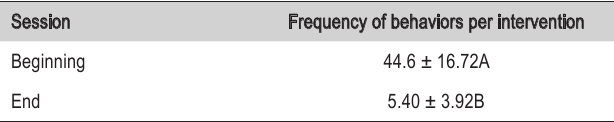
the salivary cortisol level were higher when compared to session in which the child cooperated. Table 1 - Absolute frequency average and standard deviation of uncooperative behavior by the children during the beginning and at the end of intervention session.